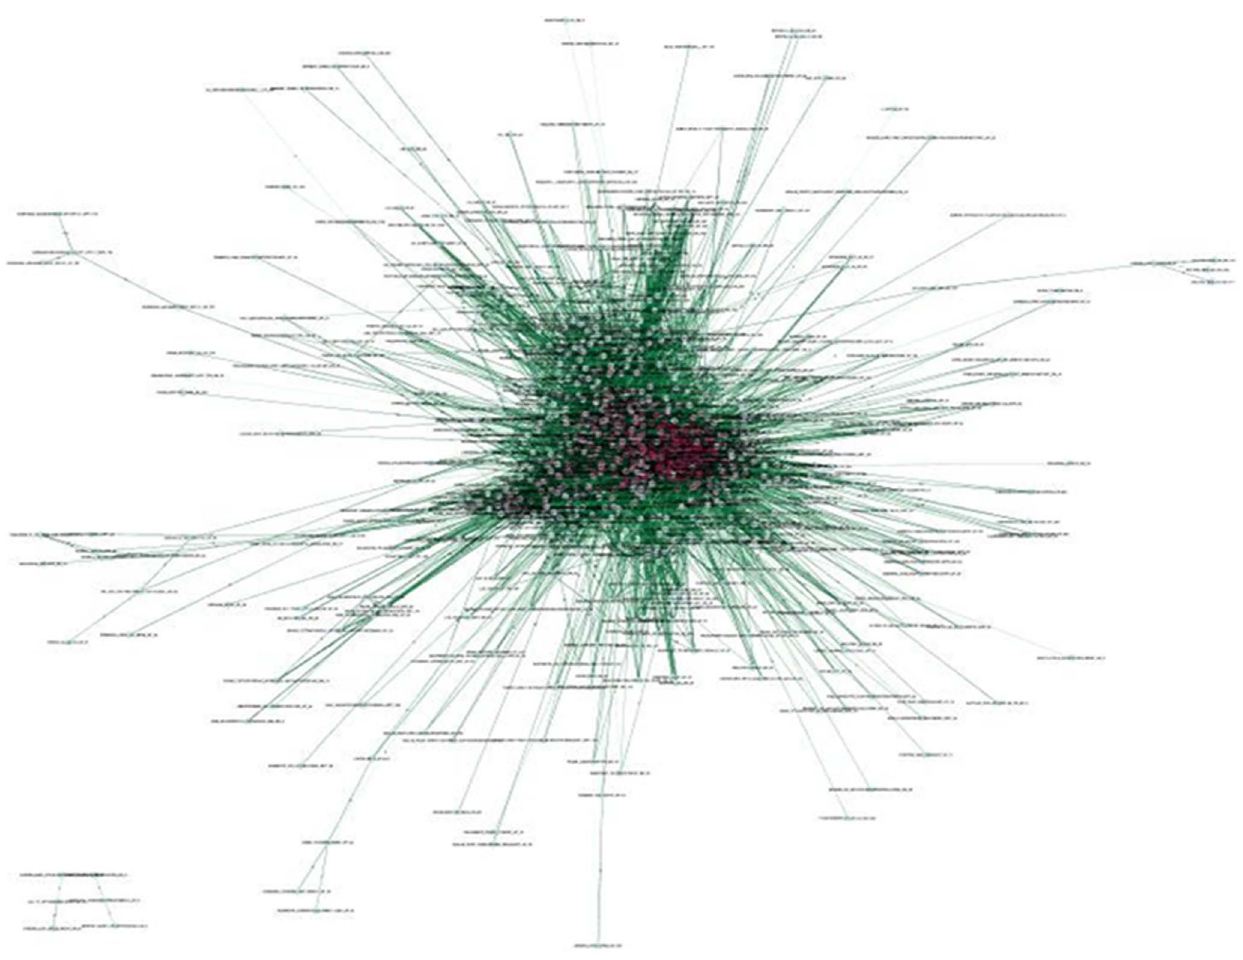
Figure 2. The main network created by Cytoscape. Node = name of gene list. Node Color = MCODE_Scores from small to large and corresponds to color from light green to dark red. Edge Color = p-values from large to small and corresponds to color from grey to dark green. Table S1 in File S1 shows its composite outcomes. There are 46